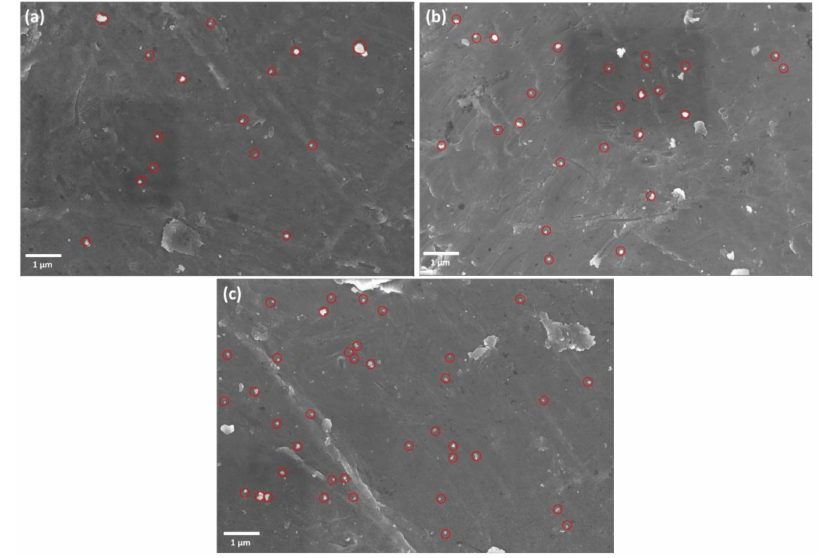
Figure 5. The scanning electron microscope (SEM) micrograph of extruded samples ( a ) Al-1wt % SiC; ( b ) Al-2 wt % SiC; ( c ) Al-3 wt %